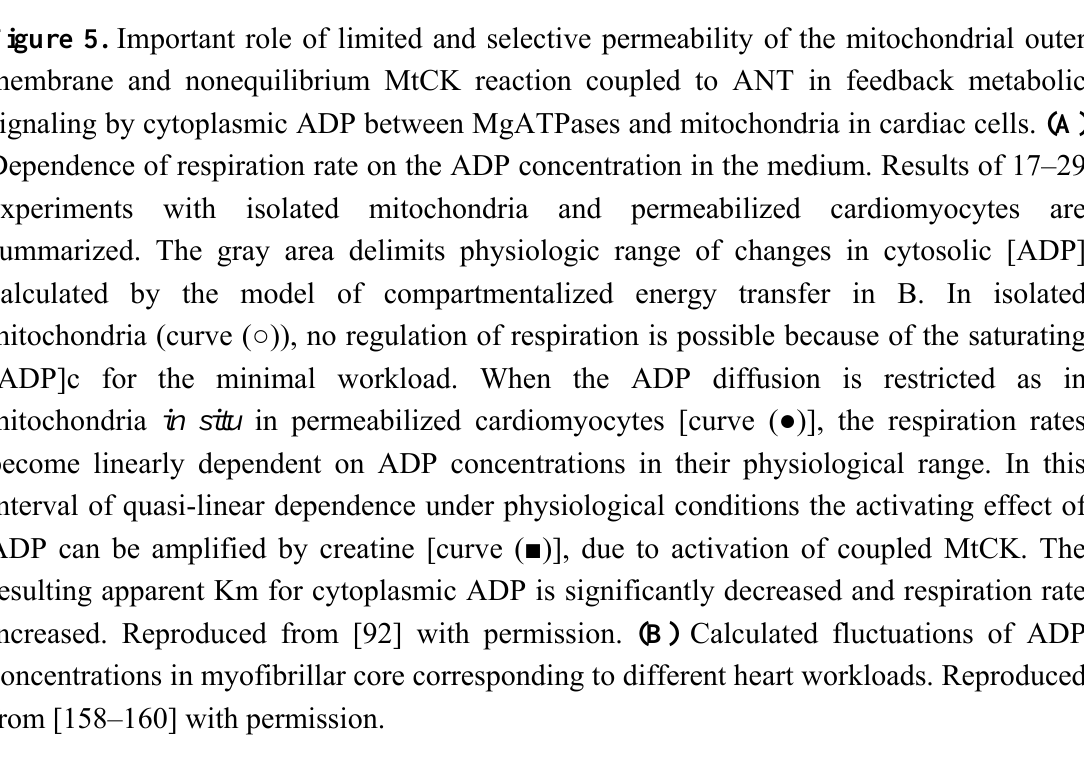
Figure 5. Important role of limited and selective permeability of the mitochondrial outer membrane and nonequilibrium MtCK reaction coupled to ANT in feedback metabolic signaling by cytoplasmic ADP between MgATPases and mitochondria in cardiac cells. (A) Dependence of respiration rate on the ADP concentration in the medium. Results of 17–29 experiments with isolated mitochondria and permeabilized cardiomyocytes are